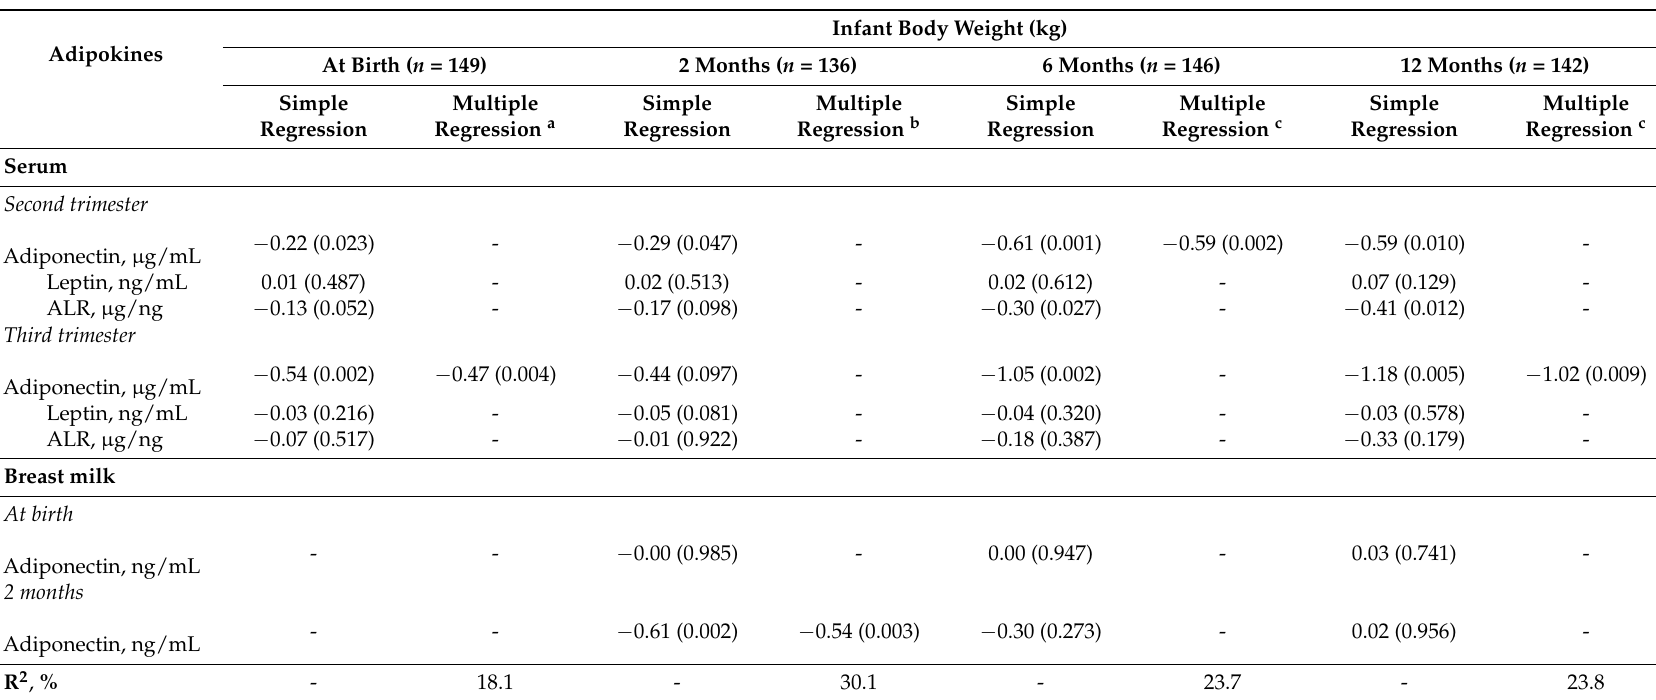
Table 3. Regression coefficients ( p -value) of maternal serum and breast milk adipokines on infant body weight.